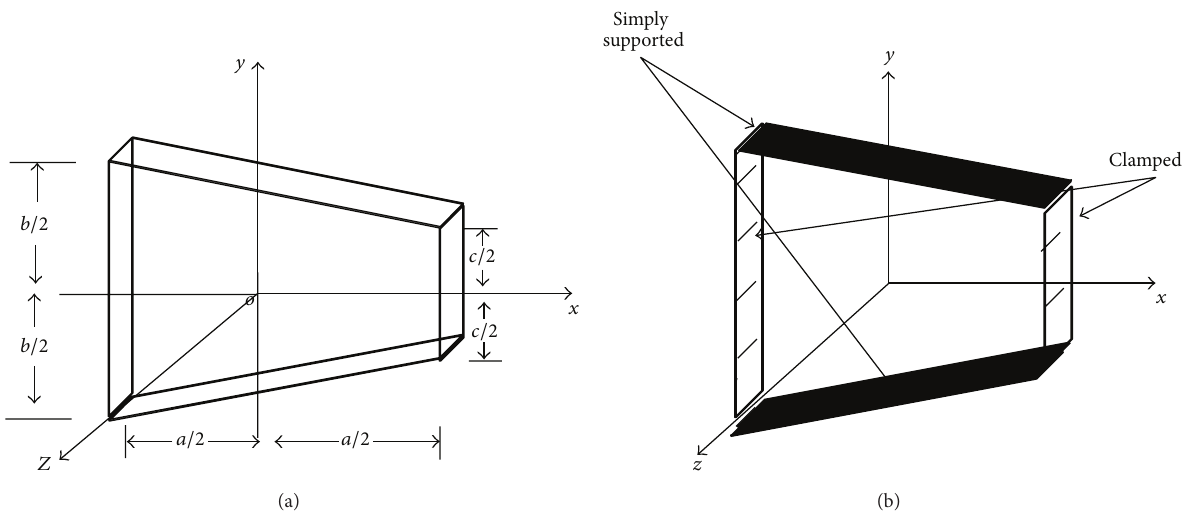
Figure 1: (a) The geometry of symmetry trapezoidal thin plate; (b) boundary conditions for the